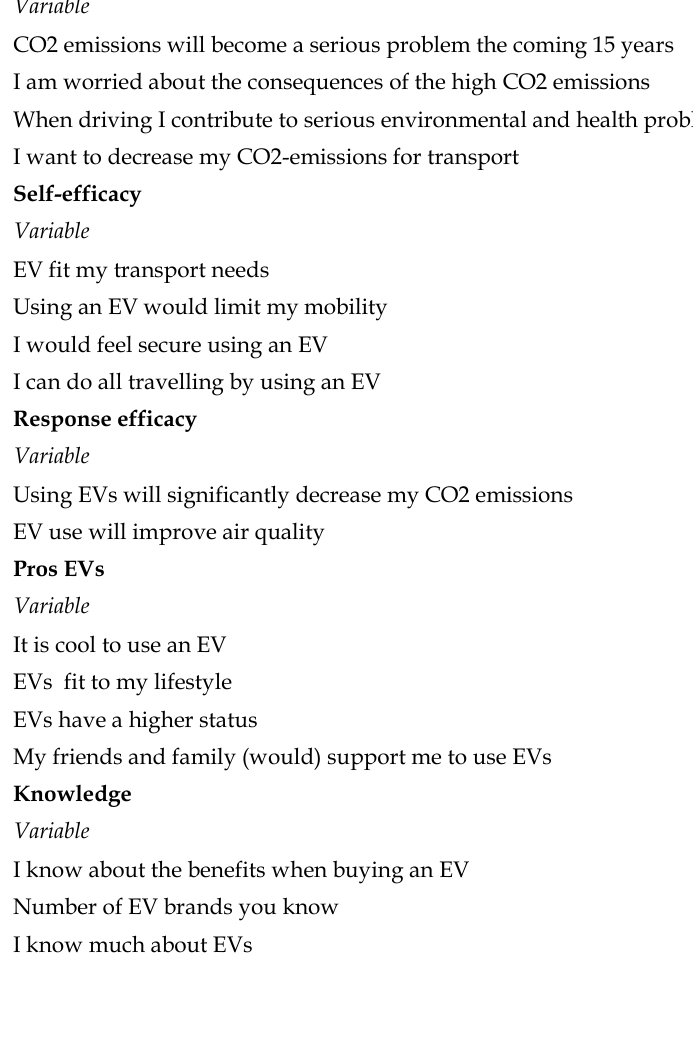
Table 6. Estimates of the 17 measurement equations of the